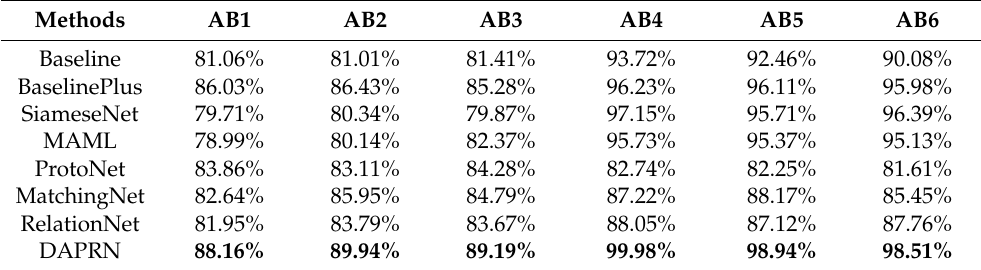
Table 8. Accuracy on one-shot fault diagnosis of transfer learning scenarios.